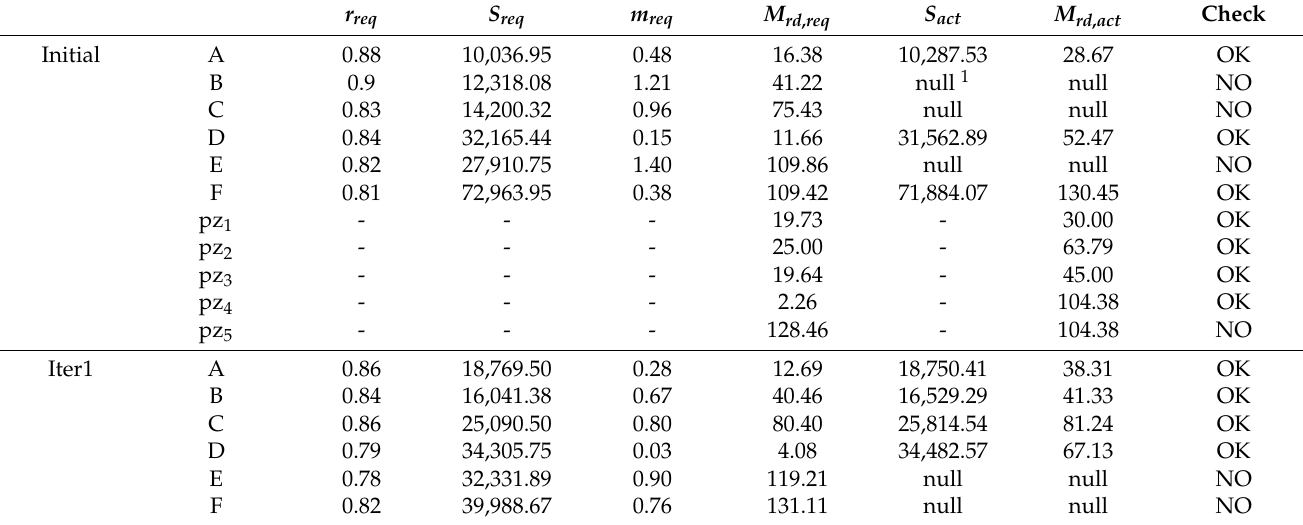
Table 8. Frame B: Required joint properties in each iteration.